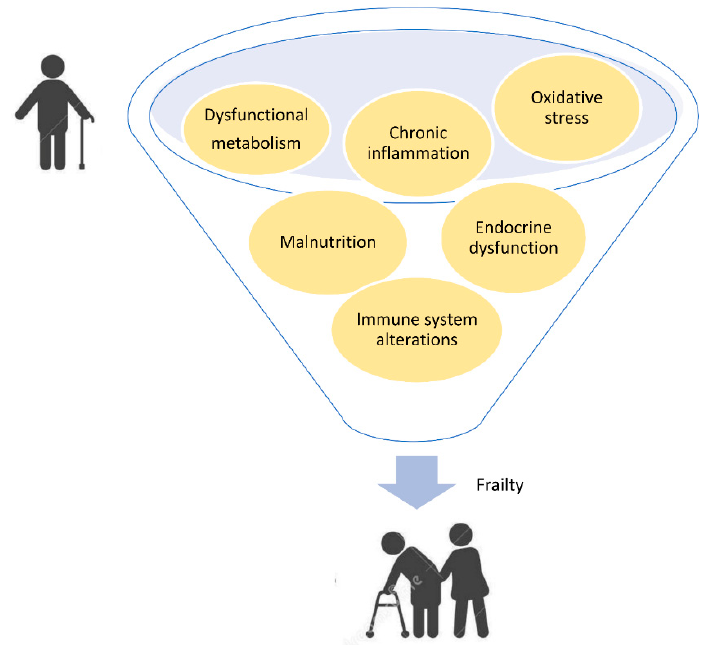
Figure 2. Impaired biological mechanisms shared among different frailty domains.